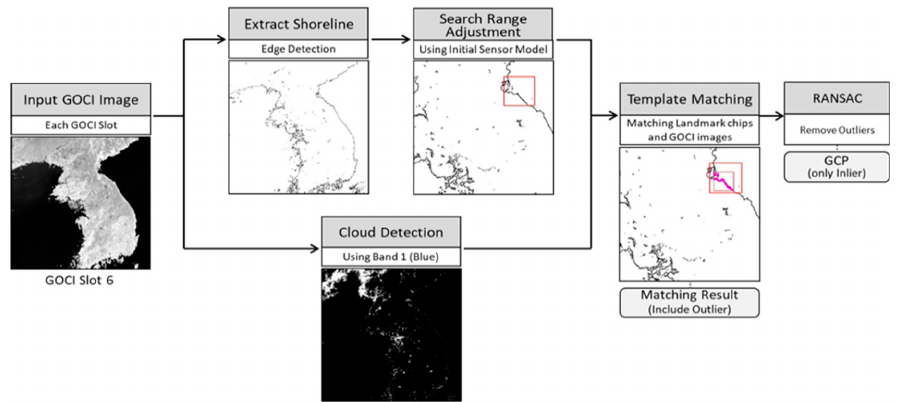
Figure 4. Shoreline matching process.